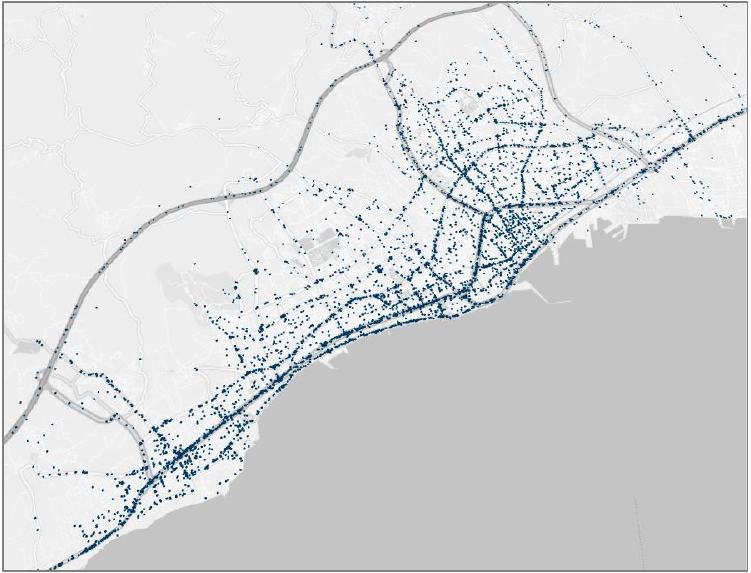
Figure 1 Spatial location accidents Source: from Ministry of Interior. General Directorate of Security. The map was prepared in MS Excel 2016.